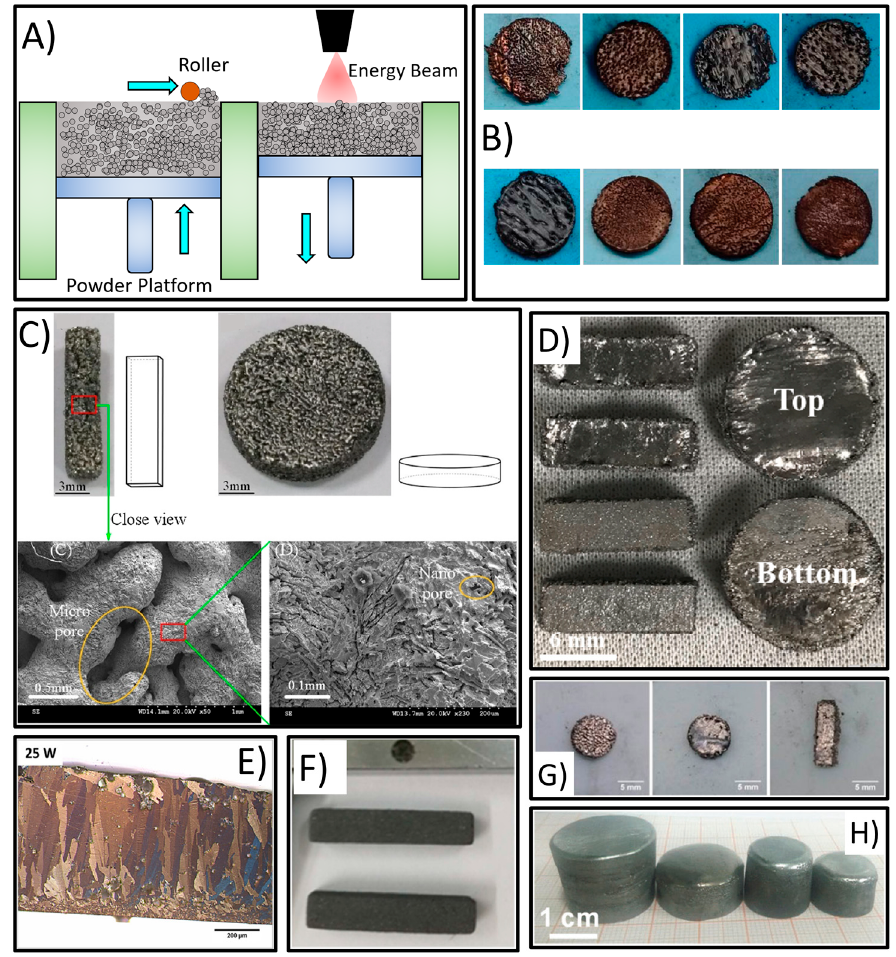
Figure 4 . ( A ) Working principle of powder bed fusion, ( B ) Nano ZrO 2 doped Hf 0.3 Zr 0.7 CoSn 0.3 Sb 0.7 bulk disks with a diameter of 8 mm and thickness over 1 mm [81], ( C ) 2 mm ‐ thick Bi 0.5 Sb 1.5 Te 3 parts and their porous microstructure (Reprinted with permission from [30]. 2019, Shi et al.), ( D ) 1 mm ‐ thick Sb 2 Te 3 samples alloyed via powder bed fusion (Reprinted with permission from [83]. 2021, Shi et al.), ( E ) Preferential grain orientation in powder bed fusion processed Bi 2 Te 3 (Reprinted with permission from [77]. 2017, El ‐ desouky et al.), ( F ) Bulk rectangular prism (4 mm × 4 mm × 20 mm) and cylinder (12.7 mm × 3 mm) samples made via laser powder bed fusion of n ‐ type Bi 2 Te 3 samples/epoxy composite powder by Xiong [86], ( G ) Bulk Bi 2 Te 3 samples (Reprinted with permission from [78]. 2018, Zhang et al.), ( H ) Bulk p ‐ type BiSbTe samples fabricated (Reprinted with permission from [87]. 2008, Qiu et al.).